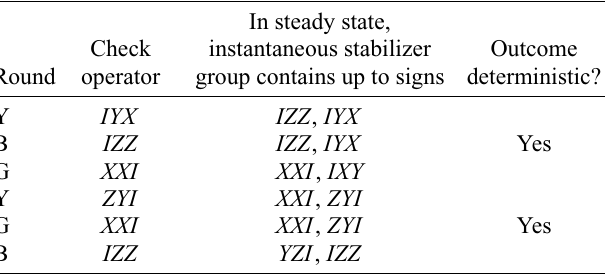
TABLE I. The elements of the instantaneous stabilizer group, restricted to the three qubits in the top left of Fig. 1(b). In two of the six rounds, the restricted instantaneous stabilizer group remains unchanged and the check outcome for that round is deterministic (in the absence of errors). For the operators in the table, the three qubits are ordered by starting with the leftmost of the three and moving